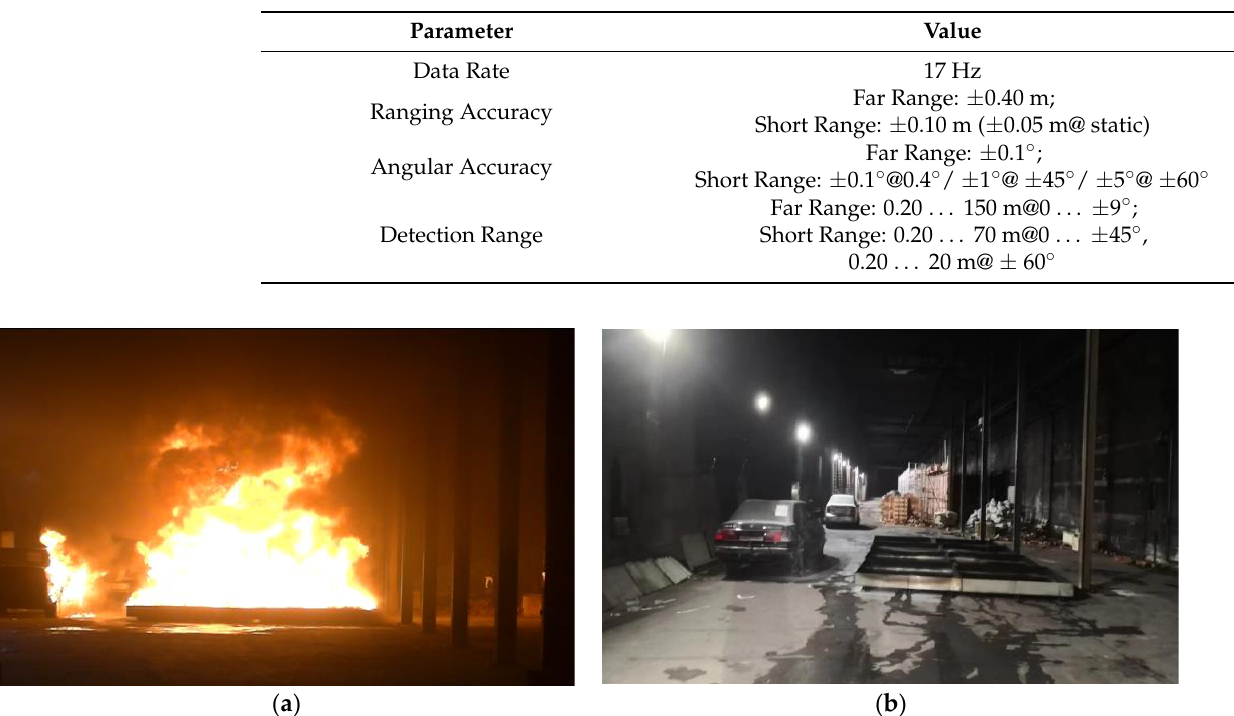
Figure 11. SLAM grid map with all radar false detections.